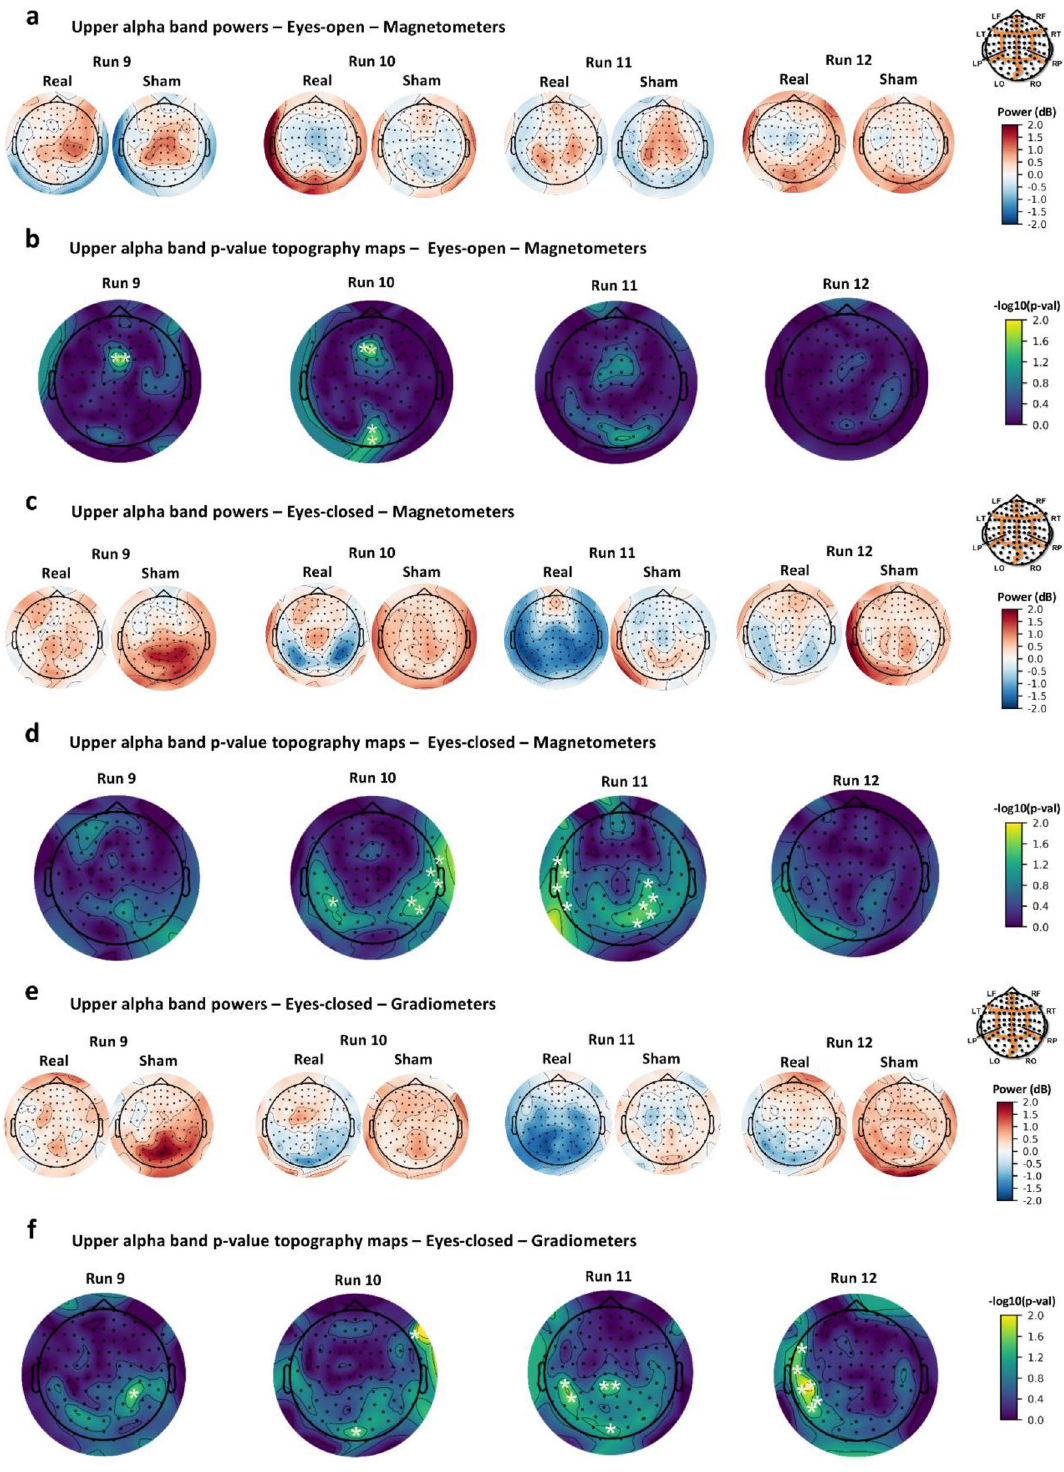
Figure 2. MEG sensor space results for the upper alpha band with magnetometers during eyes-open recordings ( a , b ), with magnetometers during eyes-closed recordings ( c , d ) and with gradiometers during eyes-closed recordings ( e , f ). Power topography maps show baseline-corrected power values computed in sensor space for each sensor during runs of the real and the sham exposure session for 29 subjects and plotted according to the 102 MEG sensor triplets layout (LF, left frontal region; RF, right frontal region; LT, left temporal region; RT, right temporal region; LP, left parietal region; RP, right parietal region; LO, left occipital region; RO, right occipital region). p value topography maps show the results of one-way ANOVA on MEG baseline-corrected upper alpha band power of RF-EMF post-exposure sessions (real vs. sham) at sensor level analysis. p values were computed for each sensor for each run (* p <